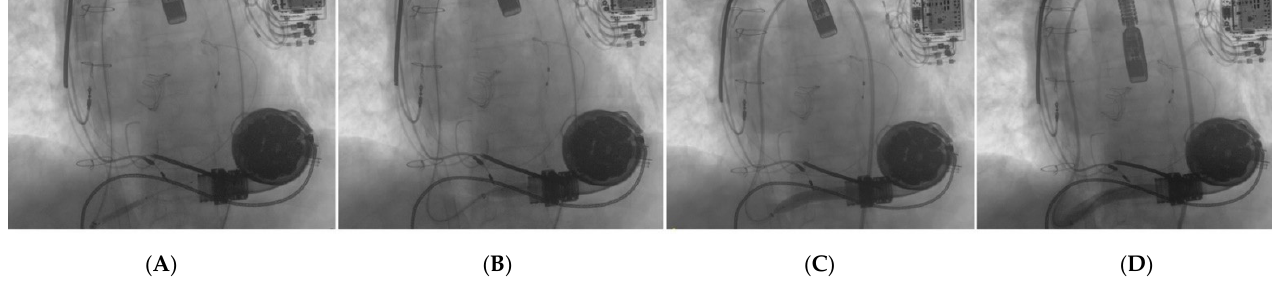
Figure 3. ( A ) the “distal balloon anchoring technique” was used to improve support for deliverability of balloon and stents. ( B ) balloon inflated at distal portion of the target lesion enabled us to advance the 8 Fr long sheath till the proximal part of the graft ( C ). a balloon-expandable covered-stent 10 × 59 mm was successfully implanted. ( D ) the delivery of the stent resulted in immediate evidence of blood-flow improvement through the outflow